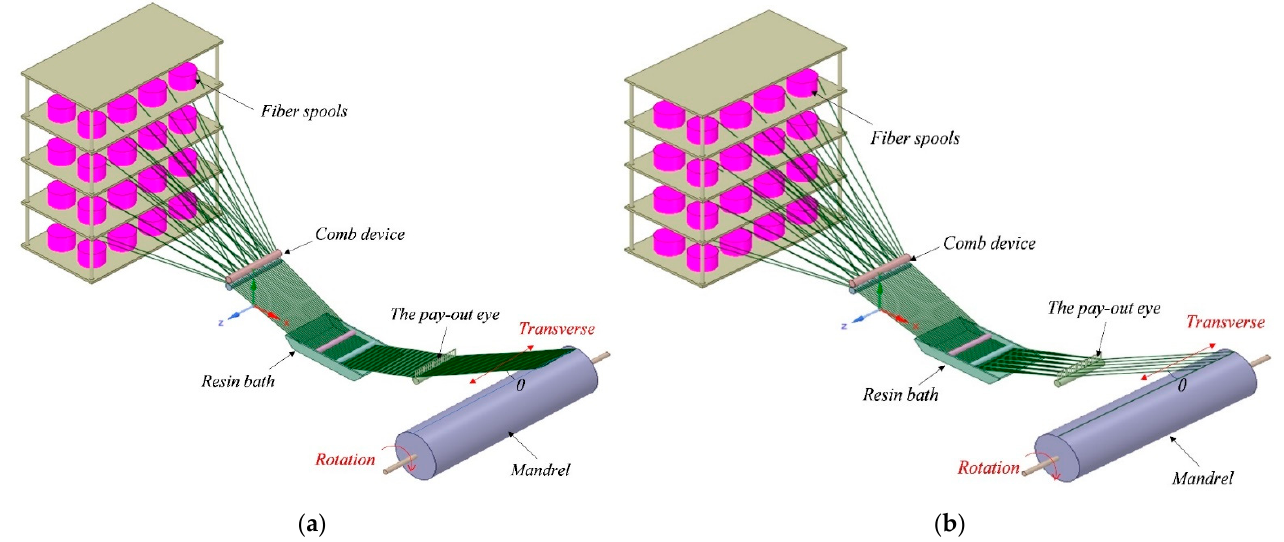
Figure 2. Schematic of manufacturing process: ( a ) Continuous arrangement winding; ( b ) spacing arrangement winding. Table 1. Mechanical properties of E-Glass Fiber and unsaturated polyester resin.